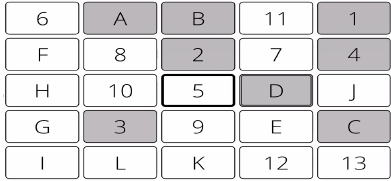
Figure 1. Layout of the online analogue of the Trail Making Test B, eTMT-B. The task requires participants to click ascending numbers and letters alternating between numbers and figures (i.e., 1-A-2-B-3-C,